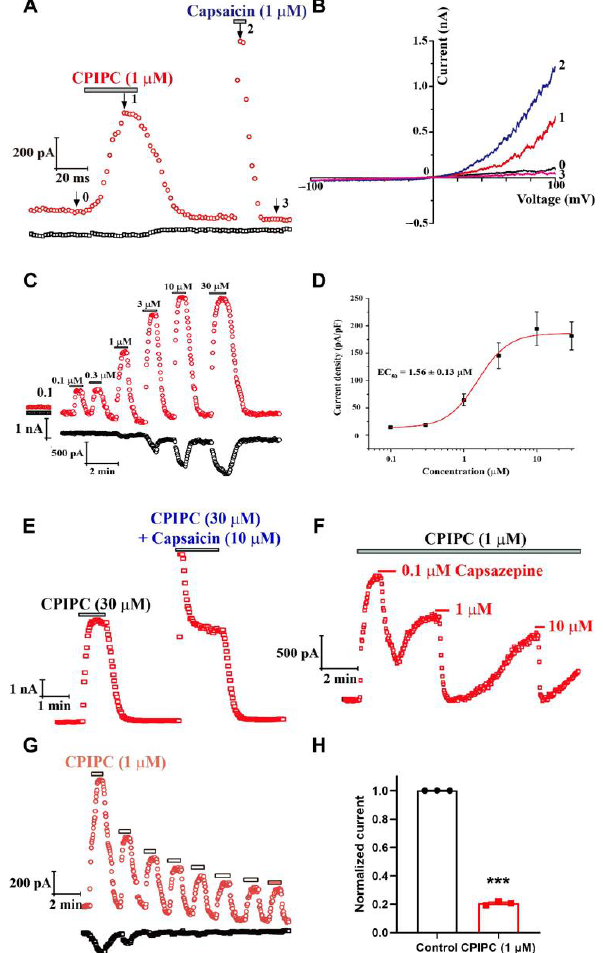
Figure 3. Concentration-dependent activation of TRPV1 by CPIPC in TRPV1 expressing HEK293 cells. ( A ) Time courses of TRPV1 current in response to 1 µ M CPIPC and capsaicin measured at +100 mV (red) and − 100 mV (black). ( B ) Representative whole-cell currents of TRPV1 in response to voltage ramps from − 100 to +100 mV under control conditions ( 0 ), 1 µ M CPIPC ( 1 ), 1 µ M capsaicin ( 2 ), and wash-out ( 3 ) as indicated in ( A ). ( C ) Time courses of TRPV1 channels activated by dif- ferent concentrations of CPIPC from 0.1 µ M to 30 µ M at +100 mV (red) and − 100 mV (black). ( D ) Curve-fitting analysis of dose-dependent activation of TRPV1 by CPIPC with an EC 50 of 1.56 ± 0.13 µ M ( n = 5). EC 50 : half maximal effective concentration. ( E ) Time course of TRPV1 current in response to 30 µ M CPIPC and 10 µ M capsaicin recorded at +100 mV. ( F ) Time course of TRPV1 current in response to 1 µ M CPIPC and TRPV1 antagonist capsazepine at 0.1, 1 and 10 µ M. ( G ) Time courses of TRPV1 current in response to repetitive applications of 1 µ M CPIPC recorded at +100 mV (red) and − 100 mV (black) in TRPV1 transiently transfected HEK293 cells. ( H ) The summary of normalized TRPV1 current after eight repetitive applications of 1 µ M CPIPC ( n = 3). ***, p < 0.001, for comparison of desensitization between the first and eighth application of CPIPC -induced